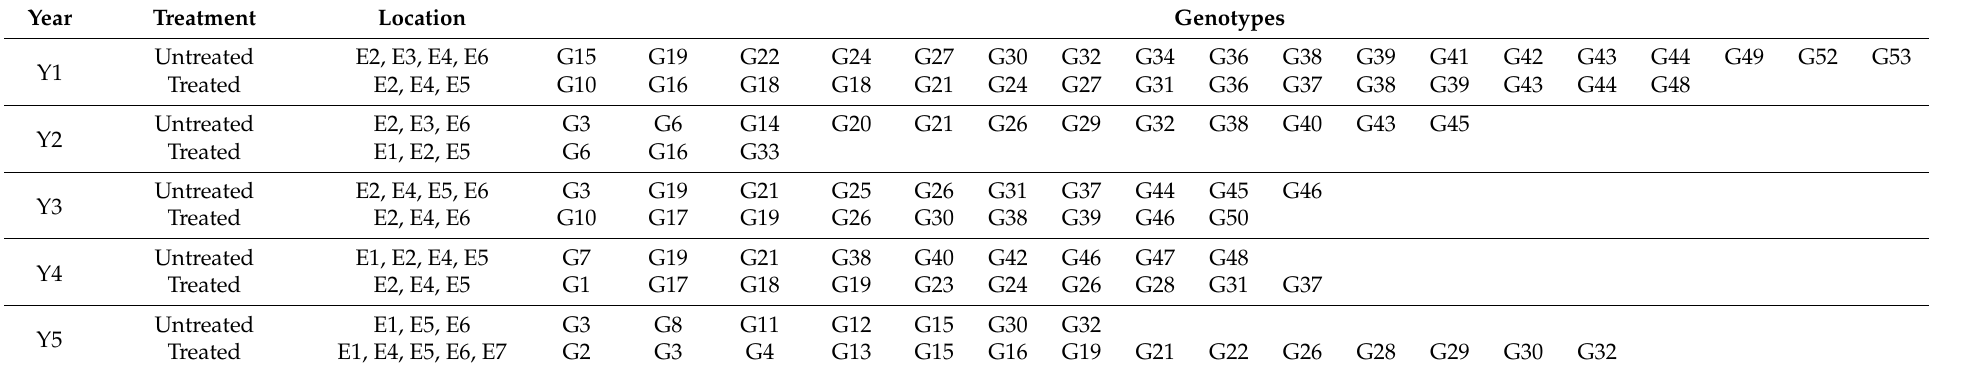
Table 5. Barley genotypes adapted to identified MEs in the five evaluated years under untreated and treated